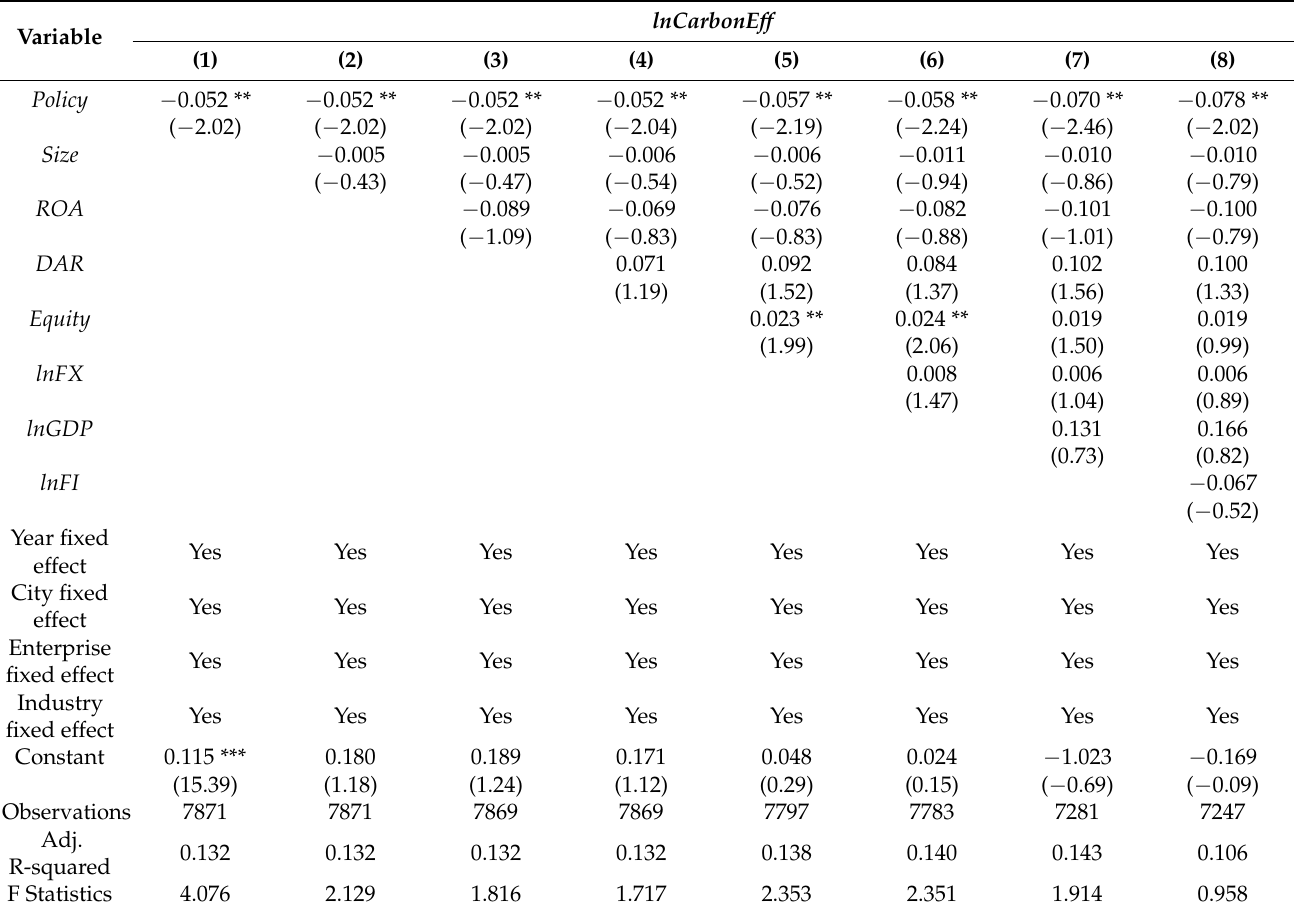
Table 3. Regression results of smart city policies and carbon emission